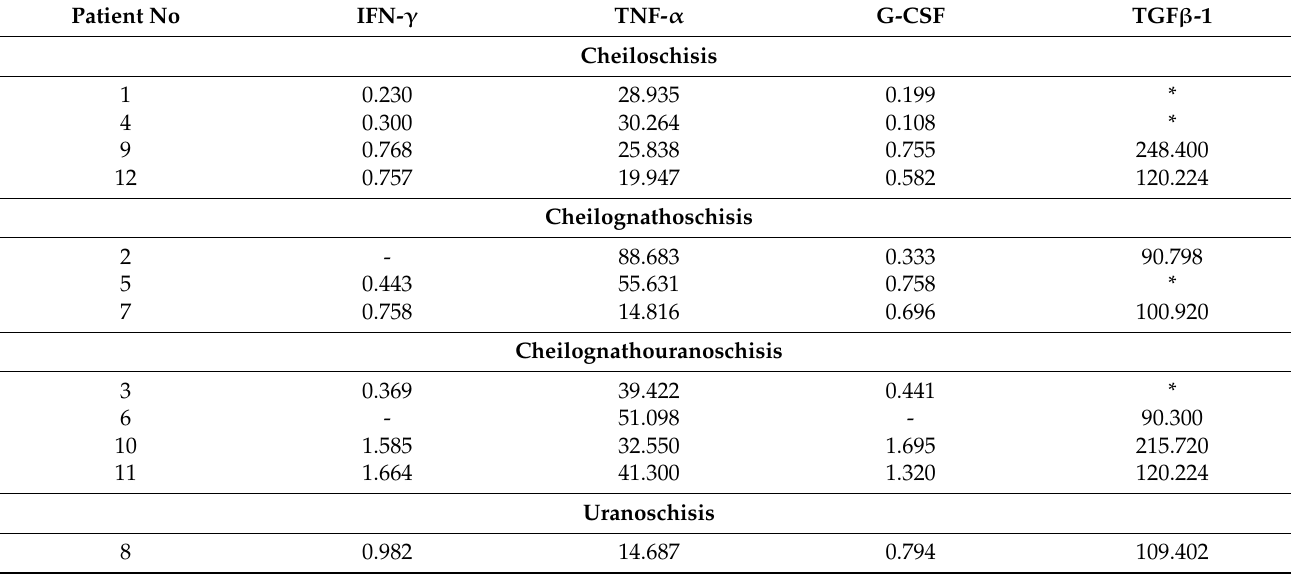
Table 4. Concentration of other cytokines in individual patients measured in pg/mL.